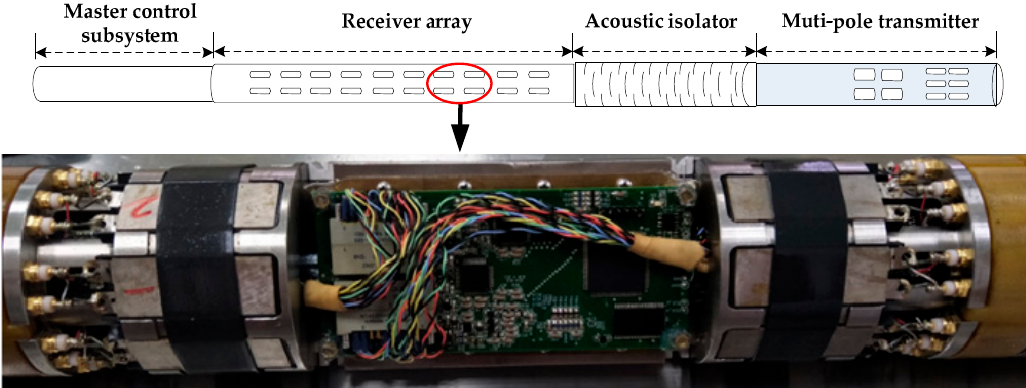
Figure 1. Structure of the 3-D acoustic logging tool.